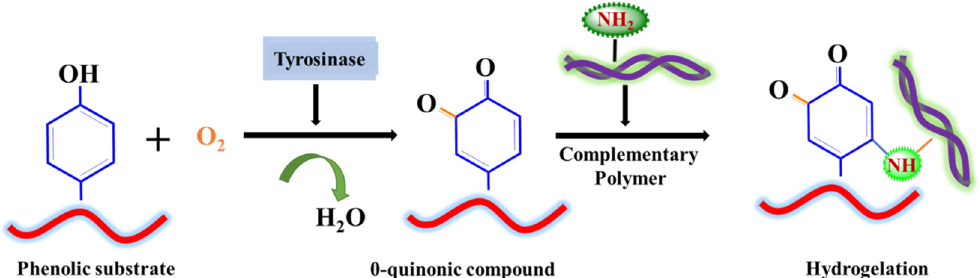
Figure 3. Mechanism of action of tyrosinase.